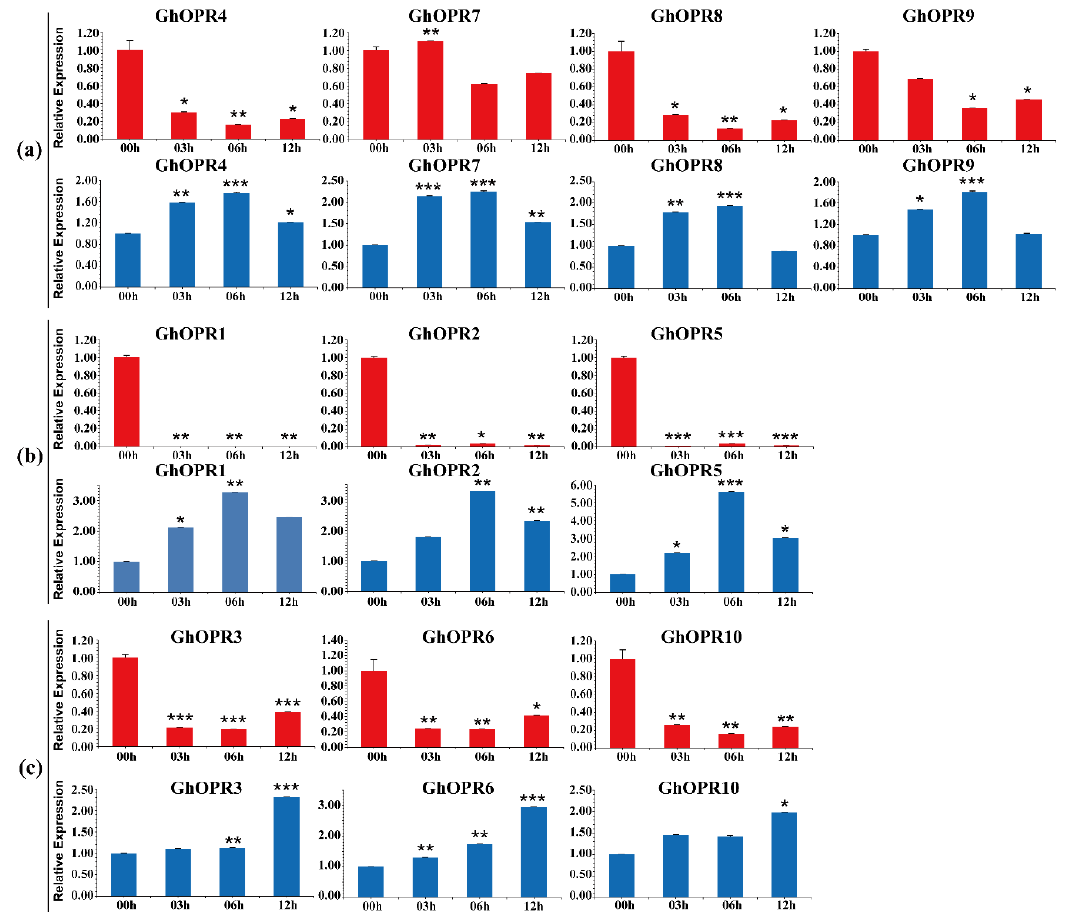
Figure 4. Analysis expression patterns of GhOPRs under abiotic stresses by Real-time quantitative PCR. ( a ) The expression levels of GhOPRs in subgroup I. ( b ) The expression levels of GhOPRs in subgroup II. ( c ) The expression levels of GhOPRs in subgroup III. The red columns represent the expression levels of GhOPRs under PEG6000 treatment; and blue columns represent the expression levels of GhOPRs under NaCl treatment. Values represent means ± standard deviation of three replicates. Asterisks reveal the gene significantly higher or lower in 3 h, 6 h, and 12 h than in 0 h by t -test (* p < 0.05, ** p < 0.01, *** p < 0.001).